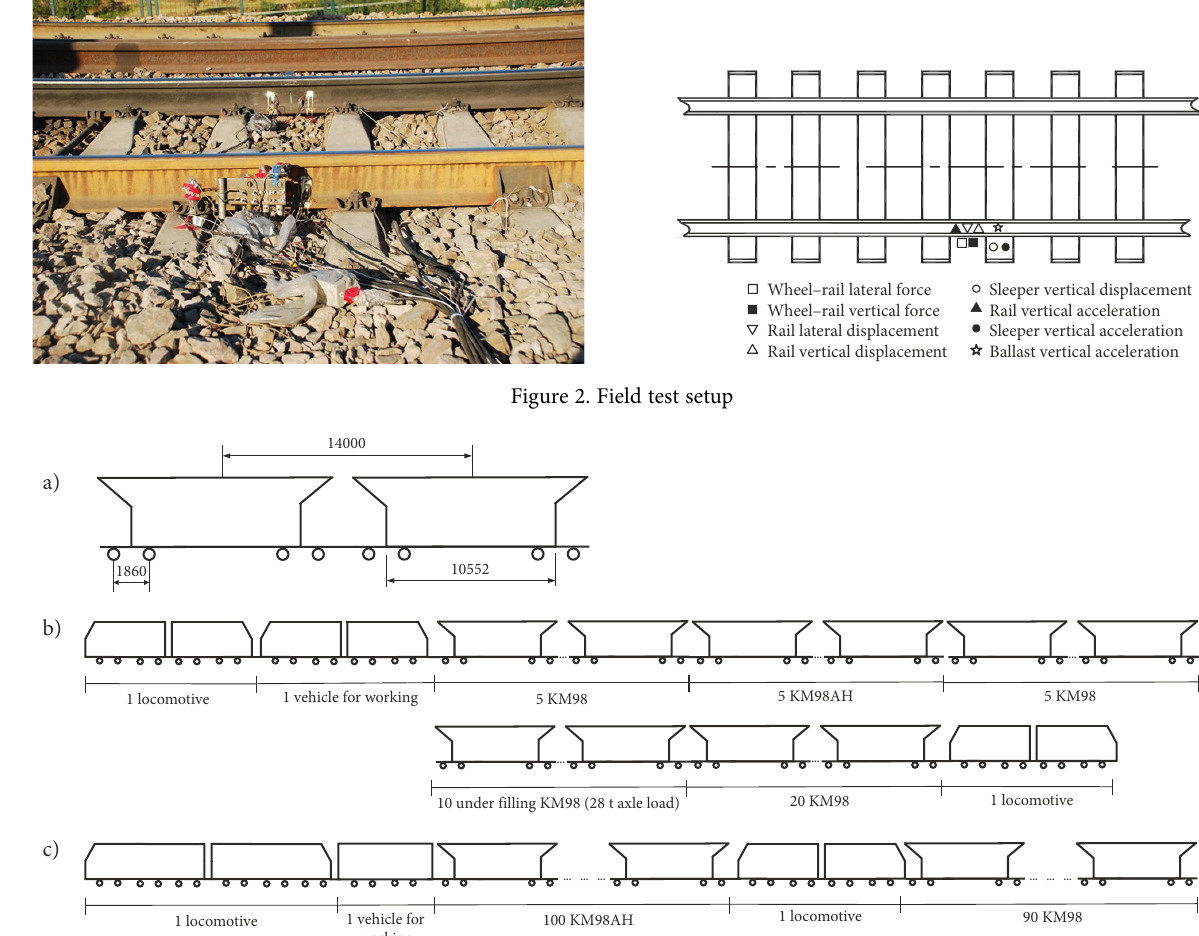
Figure 3. Formations of the test trains: a – characteristic lengths of KM98 vehicle; b – 5400 t test train; c – 23000 t test